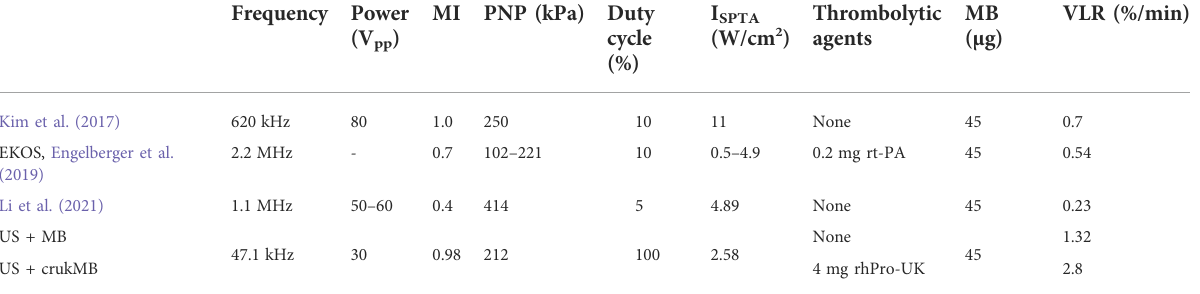
TABLE 1 Characteristics of endovascular sonothrombolysis catheter and VLR.